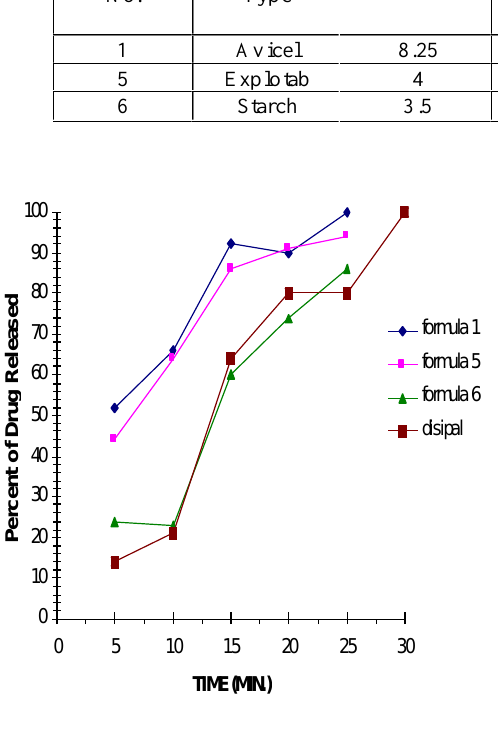
Fig. 3 : The effect of disintegrants type on the release of Orphenadrine in comparison  with the reference tablets DISIPAL Formula 5 , in which Explotab (low substituted carboxymethyl starch (32) ) was used as a disintegrant showed a relatively low hardness (4kg) with an acceptable friability (0.1%), disintegration time (5mins.) and dissolution time (25 mins.) , however , its dissolution profile showed no significant difference with formula 6 fig(3) (p – value >